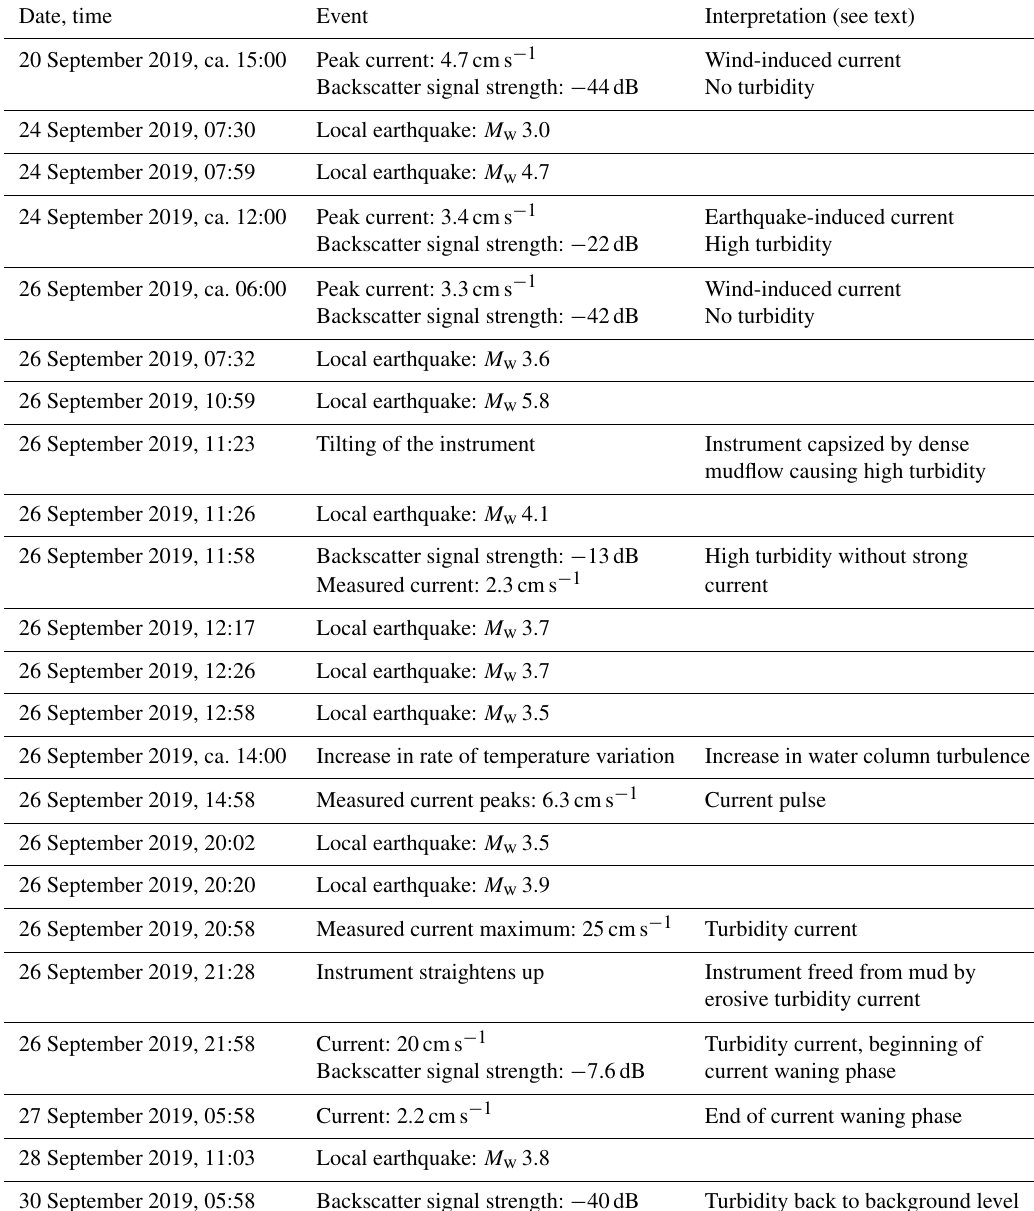
Table 1. Event chronology. Time and magnitude of earthquakes from Karabulut et al. (2021). Date,